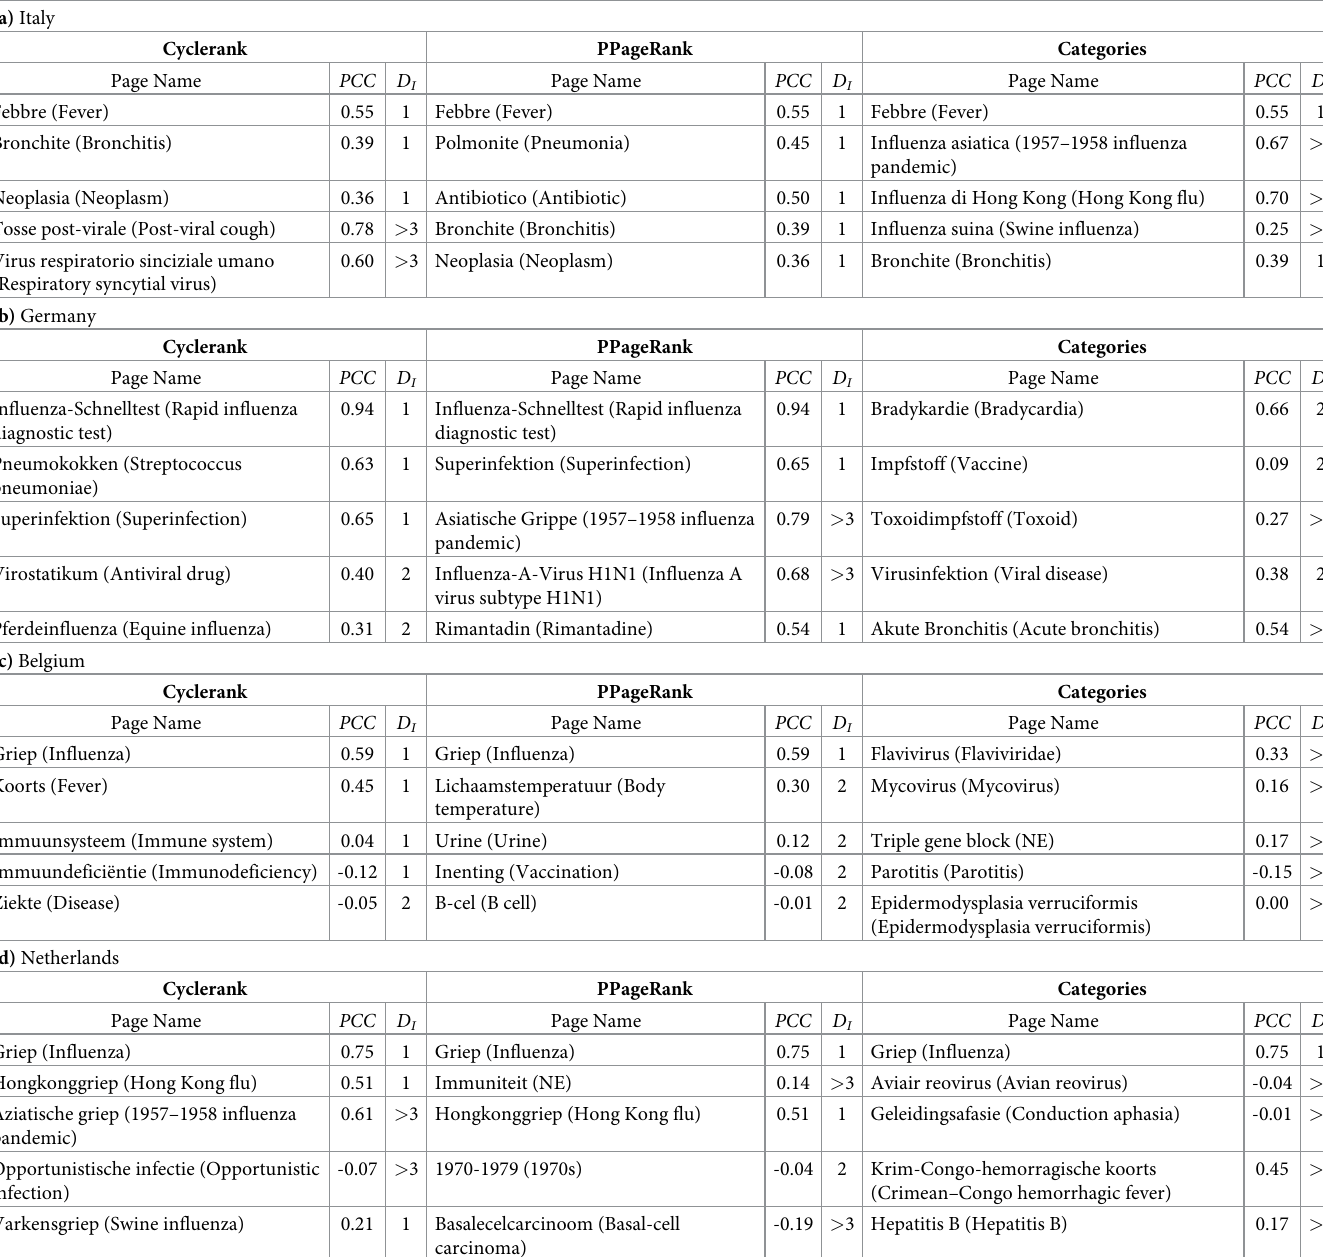
Table 7. Top-5 Wikipedia pages selected by the LASSO models for the influenza seasons from 2015 to 2019 for all the examined countries. We report only the models which performed better (see Table 3 for the best models). For each model, we report the page name, the shortest-path distance D I between the page and the corresponding “Influenza” page, and the Pearson Correlation Coefficient (PCC) measured against the influenza incidence. We also report the corresponding page in the English Wikipe- dia in parentheses. We used the value NE to specify when a page has no English equivalent. The value D I > 3 indicates that the page is more than three hops away from the “Influenza”